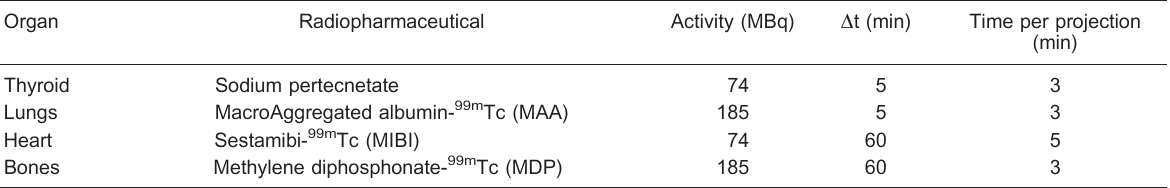
Table 1. Experimental parameters for imaging with SPEM: 16 projections and the seven-pinhole collimator imaging heads were used.